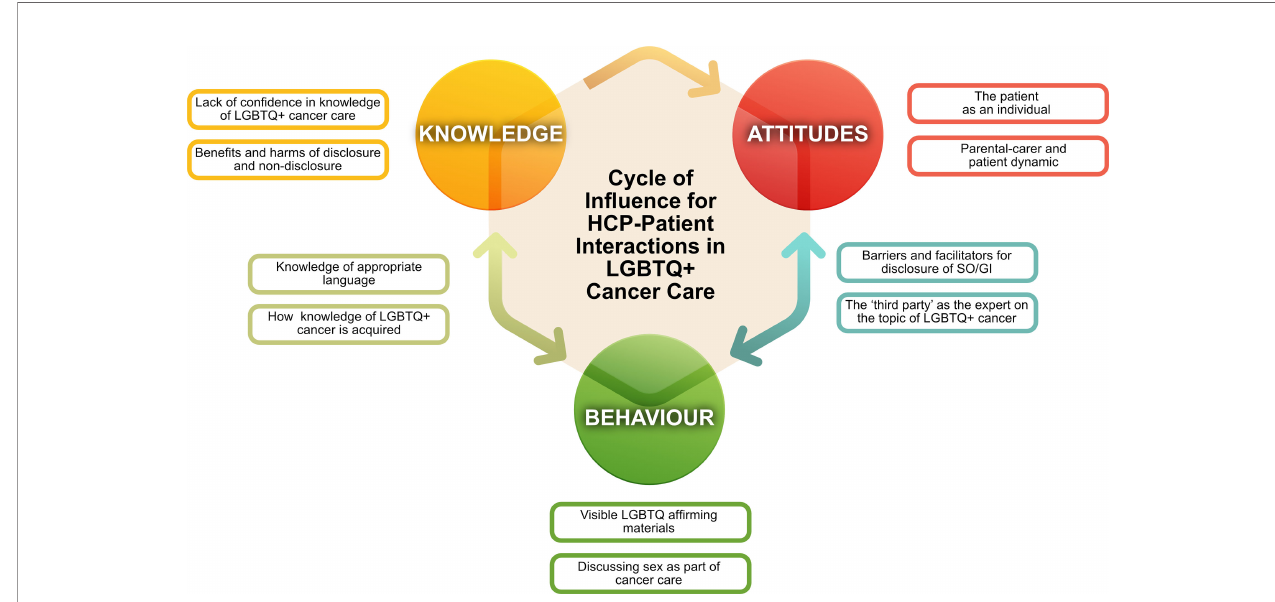
TABLE 2 | List of topics recommended to improve postgraduate education for on LGBTQ+ health and cancer care for healthcare professionals. (cid:129) LGBTQ+ terminology and appropriate language (cid:129) Why, when and how to facilitate disclosure of SO and GI (cid:129) Intersection of gender-af fi rming and cancer care (cid:129) Sex during cancer treatment (SO – sexual orientation, GI – gender TABLE 3 | Individual practice points for improving cancer care for LGBTQ+ youth. (cid:129) Ensure appropriate space for consultations. (cid:129) Ensure enough time for consultations. If not possible organise a follow up meeting. (cid:129) Aim for appropriate members of the MDT to be present in the consultation (cid:129) Enquire with CYP if they would like their carers present during the consultation. (cid:129) Offer one-on-one time with the CYP without their cares. (cid:129) Explain con fi dentiality to the CYP and abide to this when possible. (cid:129) Provide the CYP with reasoning as to why questions on LGBTQ+ identity may improve their care. (cid:129) Encourage the HCP leading in the CYP ’ s care to enquire about SO/GI and to lead by example. (cid:129) Increase dialogue amongst colleagues regarding LGBTQ+ health. (cid:129) Increase use of a psychosocial risk assessment tools to assist in asking question regarding SO and GI. (cid:129) Discuss sex and contraception in a non-heteronormative way. (CYP-Children/Young Person,MDT-Multidisciplinaryteam, SO – sexualorientation,GI – gender identity).